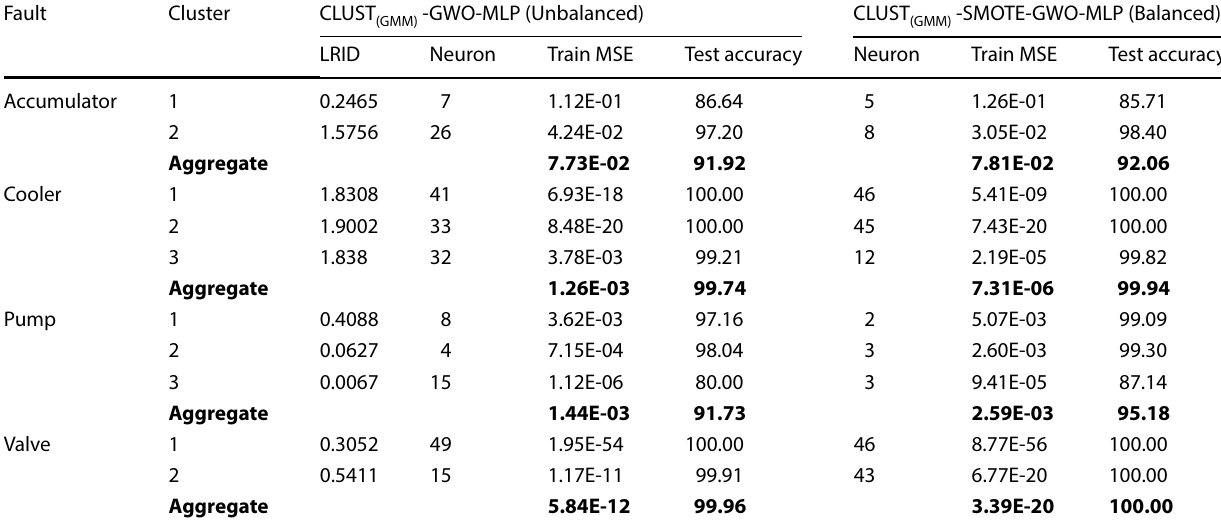
-GWO-MLP and CLUST (GMM)